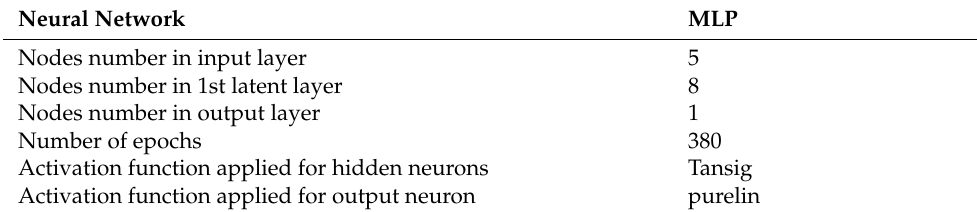
Table 2. Characteristics of the presented flow regime classifier